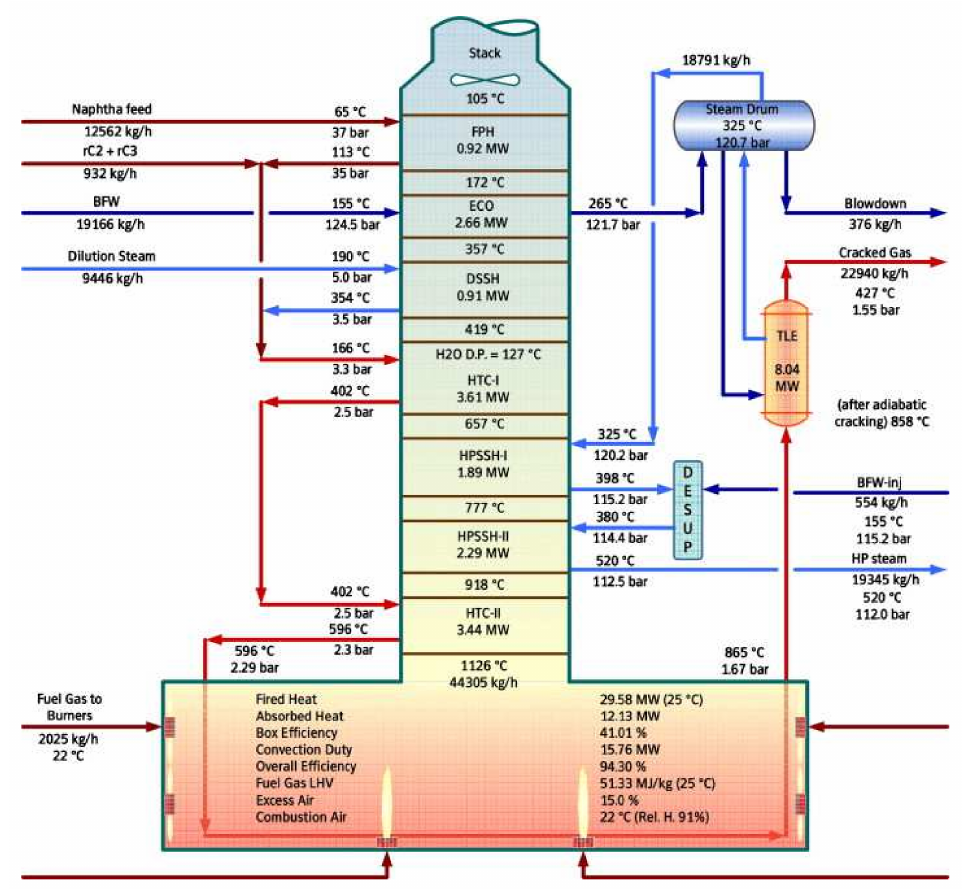
Figure 5. Thermal cracking furnace in a typical olefin plant